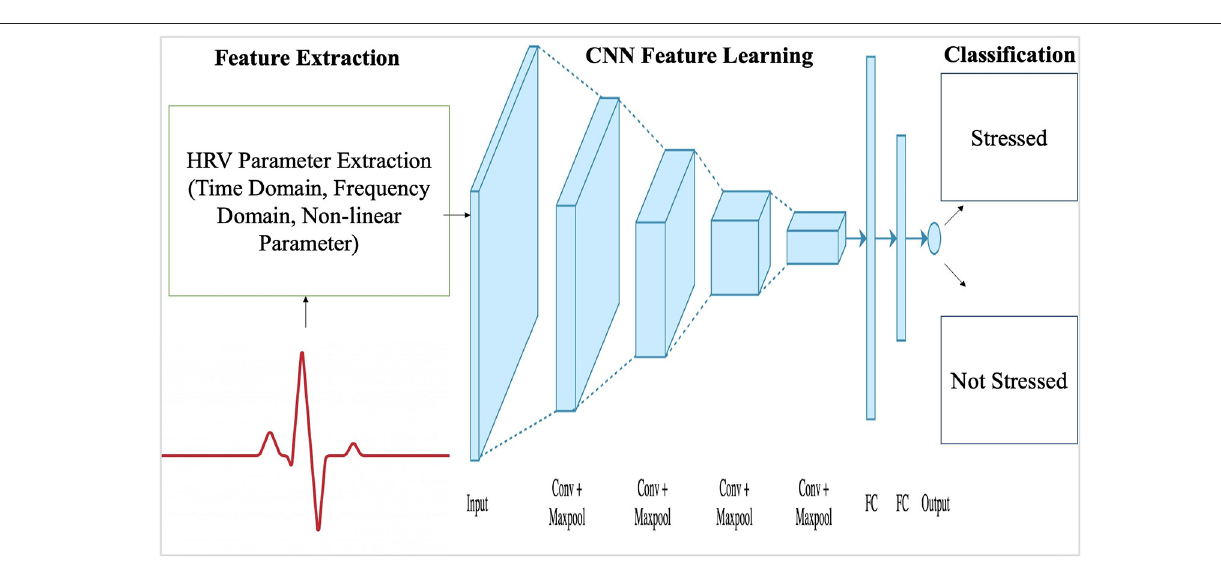
FIGURE 11 | An example of a CNN algorithm process flow chart. Source: Aishwarya